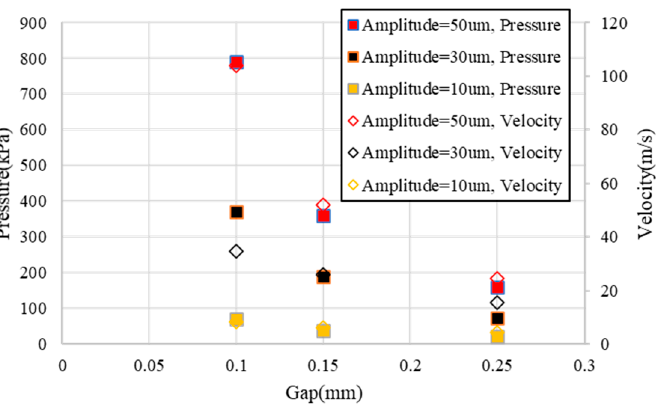
Figure 3. Variation of the maximum speed and pressure with respect to the amplitude and gap.